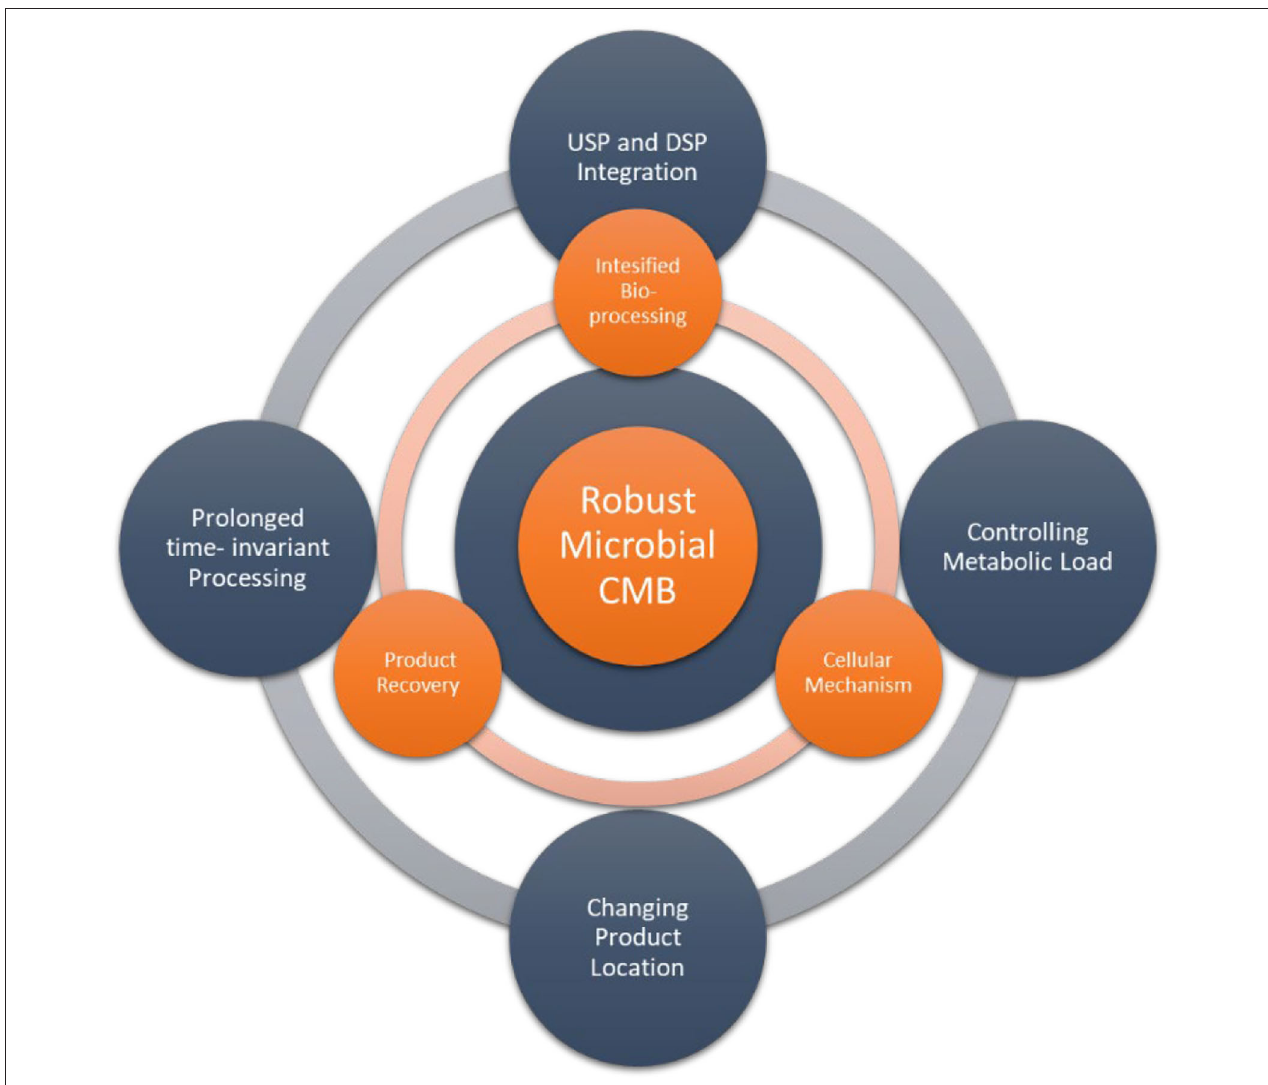
FIGURE 1 | Challenges (outer circle) and in the current topic addressed scientific advancements (inner circle) for enabling robust microbial continuous biomanufacturing